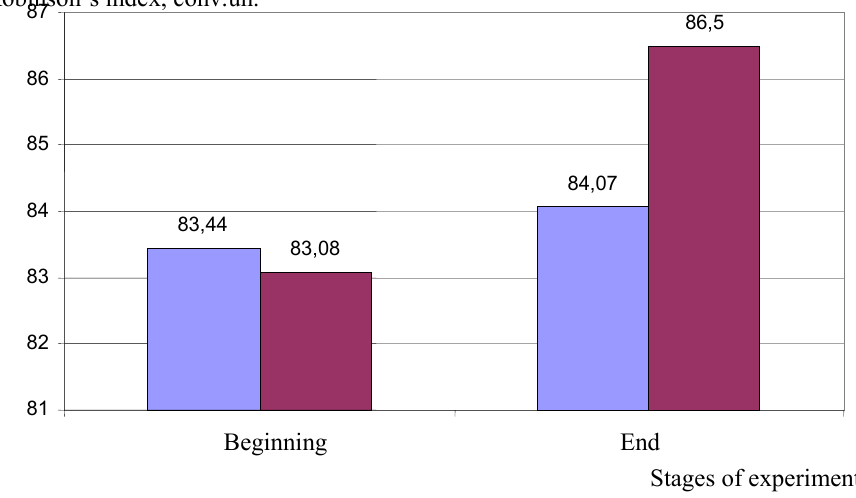
Beginning End Stages of Fig.1. Dynamic of Robinson’s index indicators of peace makers, who fulfilled mission in mountains (EG and CG) in the course of experiment (conv.un.)